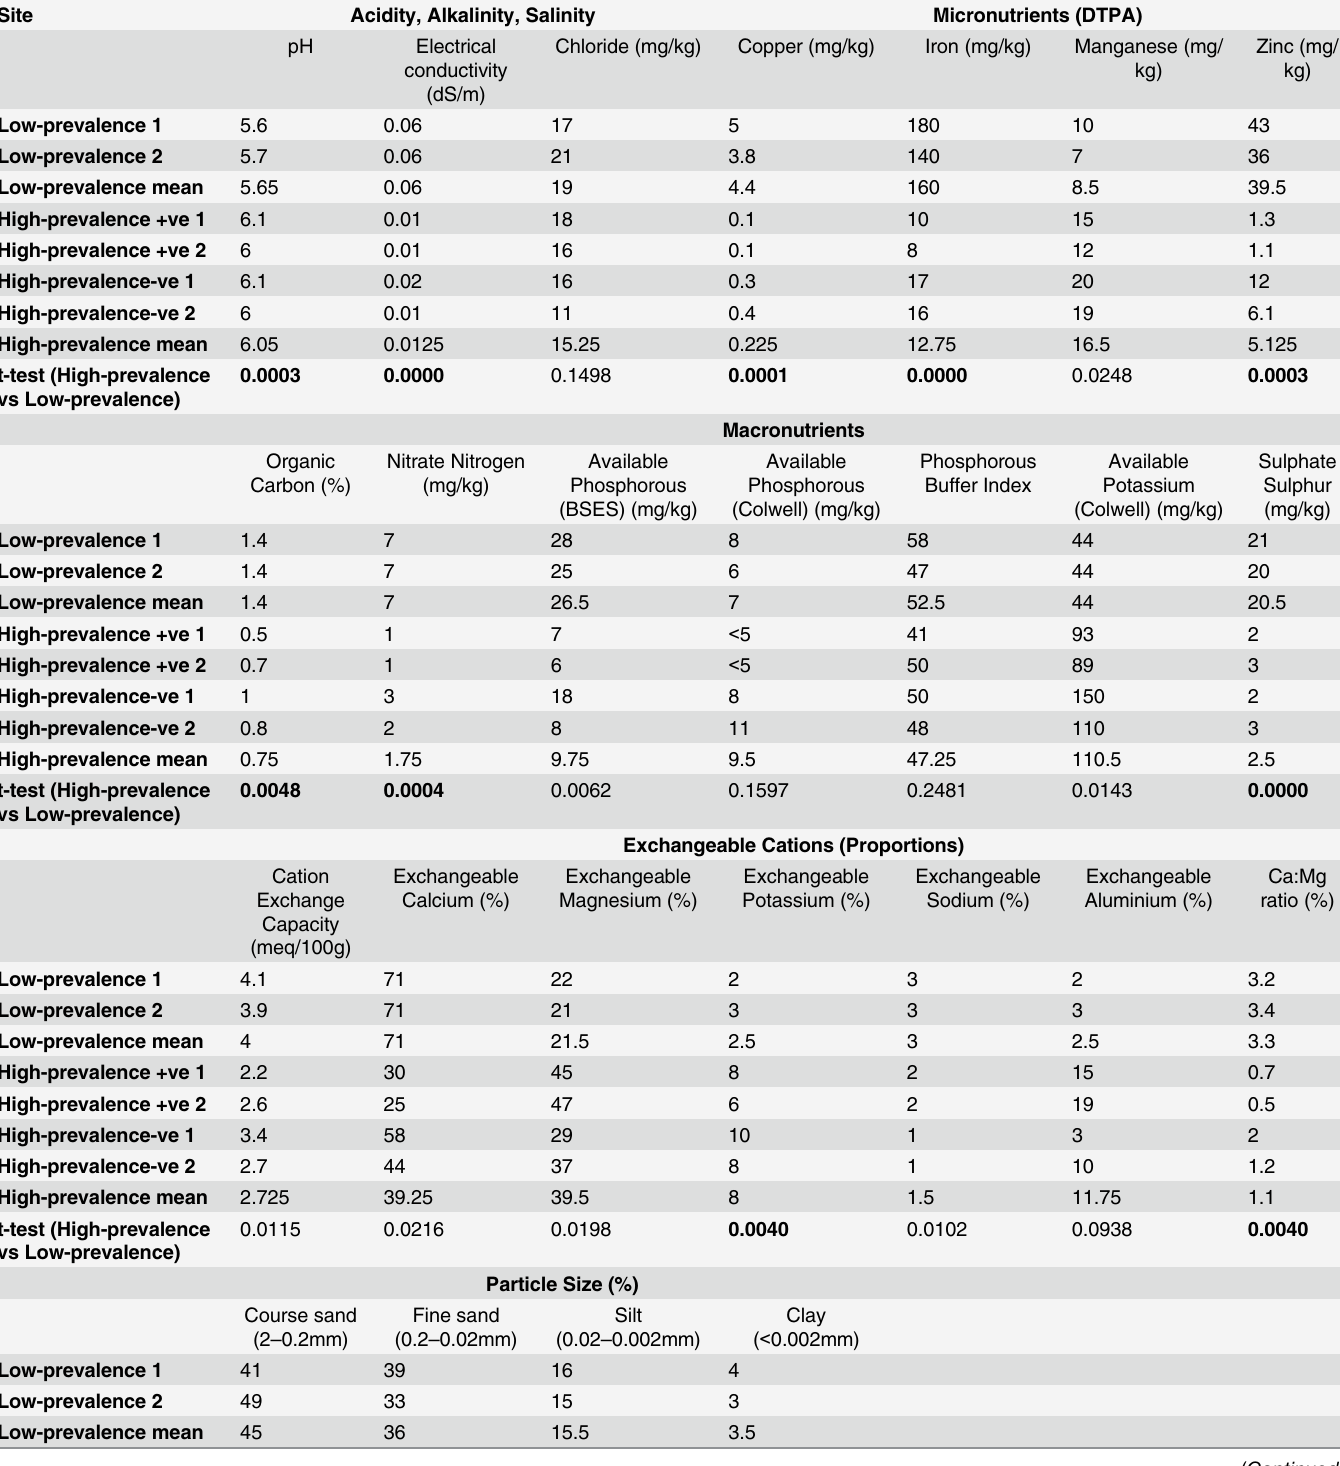
Table 1. Duplicate dry season soil physiochemical attributes from a site with a high-prevalence of Burkholderia pseudomallei (qPCR +ve soil sam- ples vs. qPCR-ve soil samples) and a site with a low-prevalence of the organism (all qPCR-ve soil samples), which is inundated regularly with groundwater containing a large quantity of viable Burkholderia pseudomallei . Statistically significant p-values are identified in bold